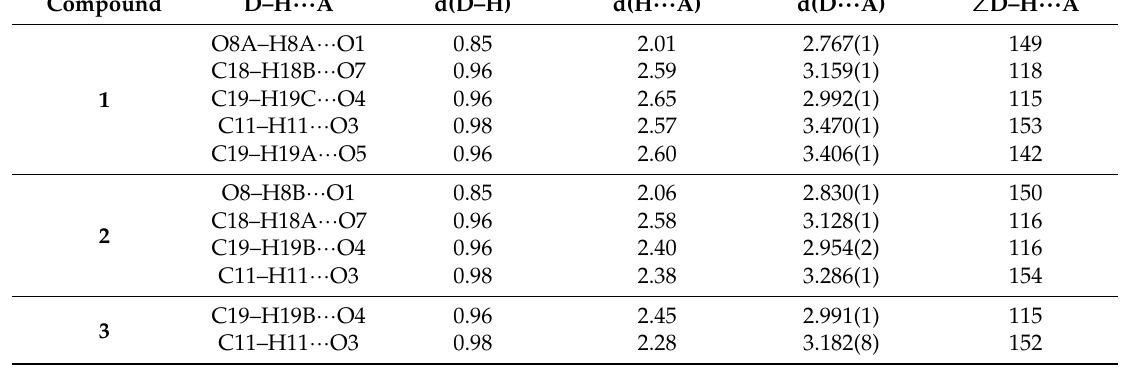
Table 3. Main hydrogen bonds [Å, ◦ ] for Mn III complexes 1 , 2 , and 3 .